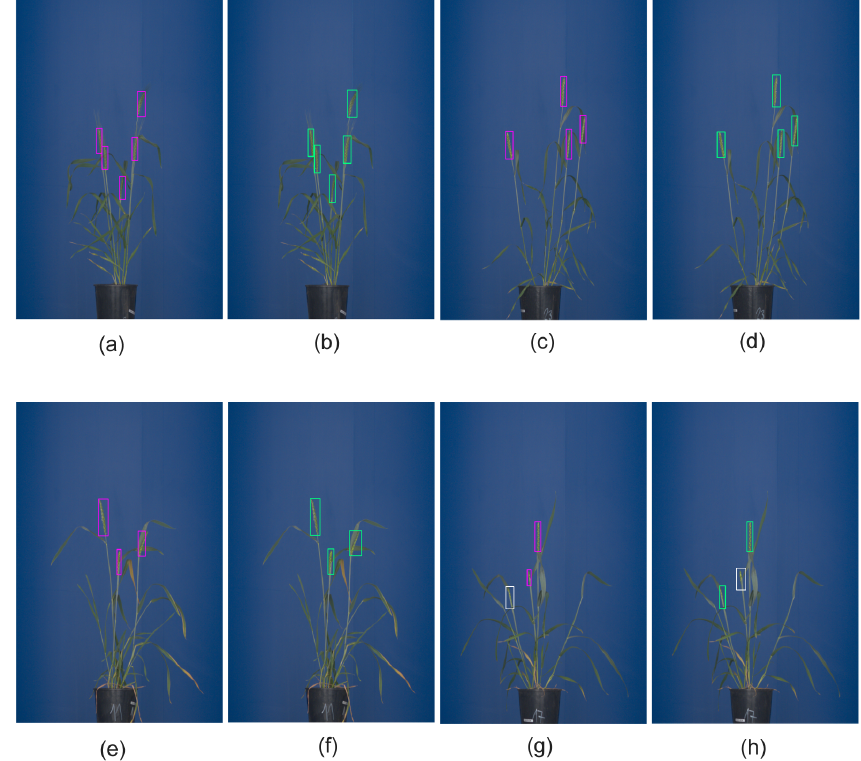
Figure 4. The detection of grain spikes using pre-trained Faster-RCNN (green bounding boxes) and YOLO (pink bounding boxes) DNN: ( a – d ) examples of detection of top wheat spikes, ( e – h ) examples of detection of emergent wheat spikes White bounding boxes indicate spikes that were not detected by the DNN classifier in this particular image.